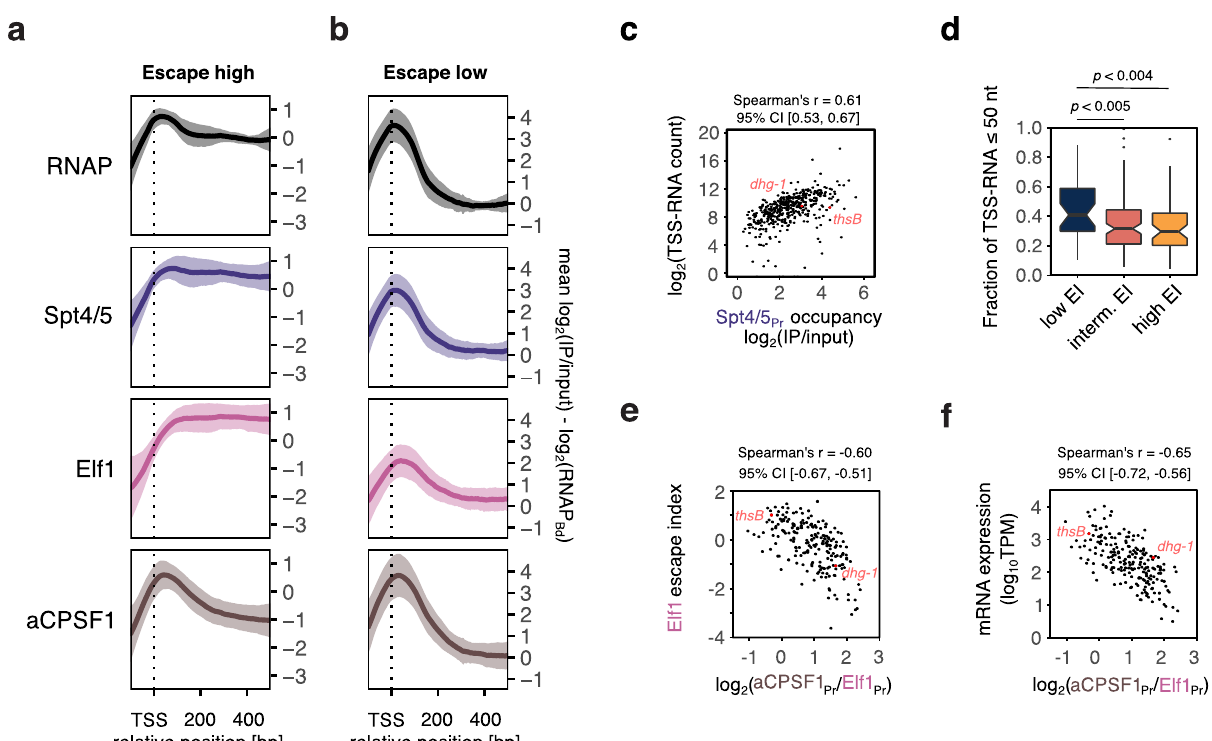
Fig. 3 Promoter-proximal elongation determines RNAP escape. a , b Recruitment of elongation factor Spt4/5 precedes Elf1 and aCPSF1 recruitment to the TEC. Aggregate plots for TUs with high (EI RNAP > − 1, n = 58) ( a ) and low escape indices (< − 2.5, n = 41) from the set of 212 TUs analysed in Fig. 2 ( b ). Before averaging across TUs, RNAP, Spt4/5, Elf1 and aCPSF1 ChIP-seq occupancy was scaled to the average RNAP occupancy within the body of each speci fi c TU (RNAP Bd ). The pro fi les thus represent the relative recruitment of the factors to the TEC. Lines represent mean values across TUs with 1x standard deviation shown as semi-transparent ribbon. Data are from a single representative of two biological replicates. c Scatter plot depicting the correlation between Spt4/5 Pr and TSS-RNA ( n = 438). Data represent the mean of two biological replicates. d TSS-RNA length distribution correlates with TEC escape. Boxplots depicting the fraction of TSS-RNAs smaller than 50 nt for TUs with low, intermediate, and high RNAP escape. Boxplots represent median, interquartile ranges and Tukey-style whiskers. Statistical signi fi cance of the observed differences was tested using a one-sidedwilcoxon rank sum test. ** p < 0.01. The number of TUs in each EI category was 35 (low EI), 109 (intermediate EI) and 56 (high EI). Data represent the mean of two biological replicates. e Scatter plots depicting the anticorrelation between Elf1 EI (mean of two biological replicates) and the relative load of aCPSF1 on the Elf1-bound TEC calculated as aCPSF1 Pr to Elf1 Pr ratio (geometric mean of two biological replicates, n = 212 genes). f Correlation of aCPSF1 load (aCPSF Pr /Elf1 Pr ) to mRNA expression levels (mean of two biological replicates, n = 211